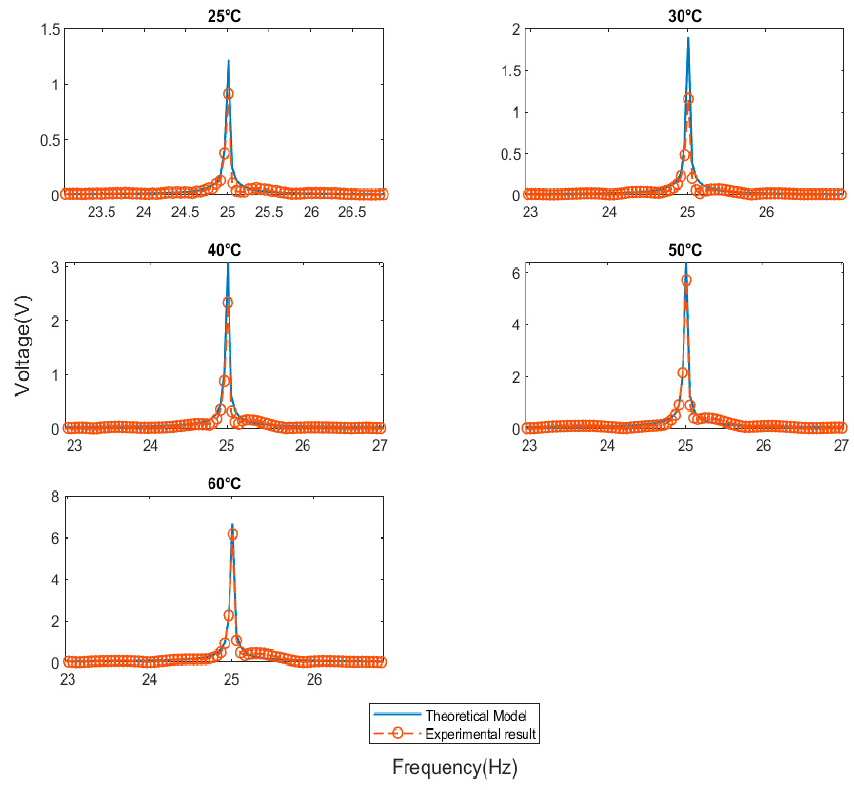
Figure 3. Comparison between the experimental and the model simulation results of voltage obtained at different temperature ranges at 25 Hz frequency.